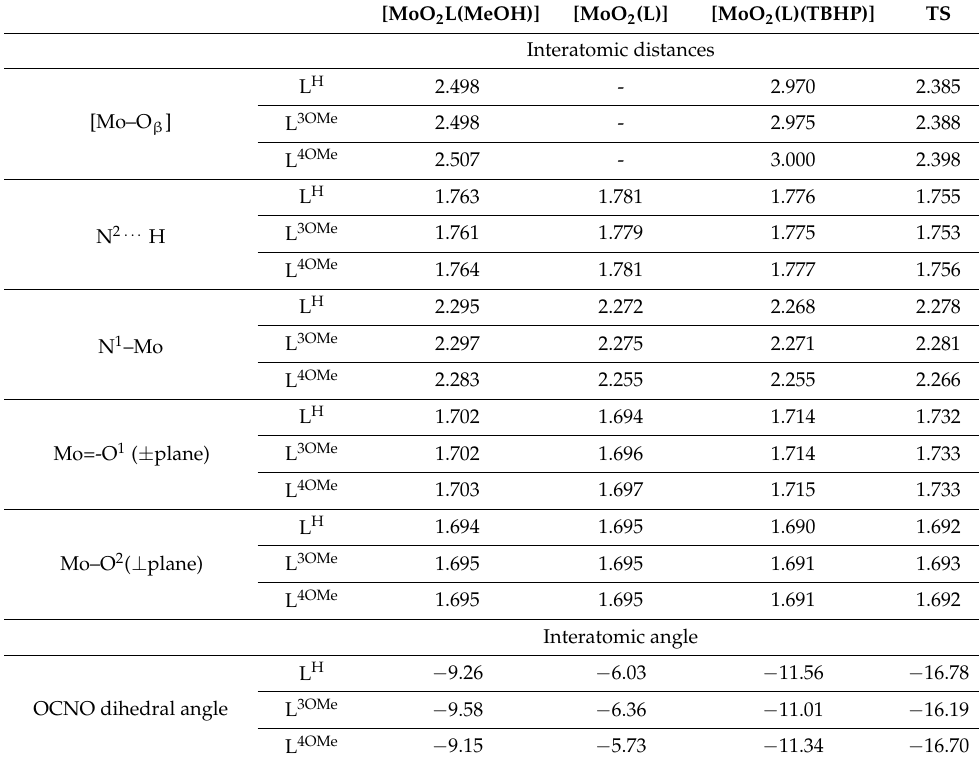
Table 4. Interatomic distances (Å) and dihedral angle ( ◦ ) for the calculated structures according to Scheme